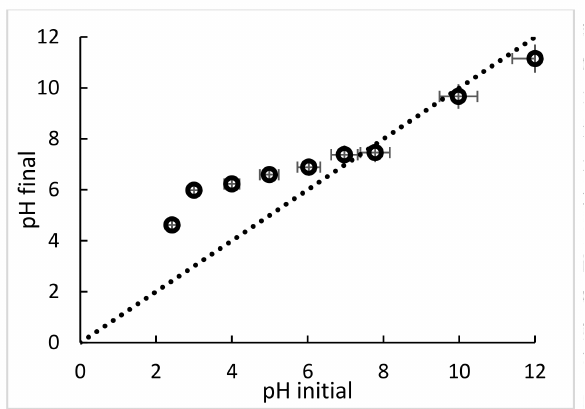
Figure 4. pH pzc of ChiFer(III). ( T : 20 ◦ C; sorbent dosage: 1 g · L − 1 ; agitation speed: 180 rpm; contact time: 24 h; 0.01 M NaCl